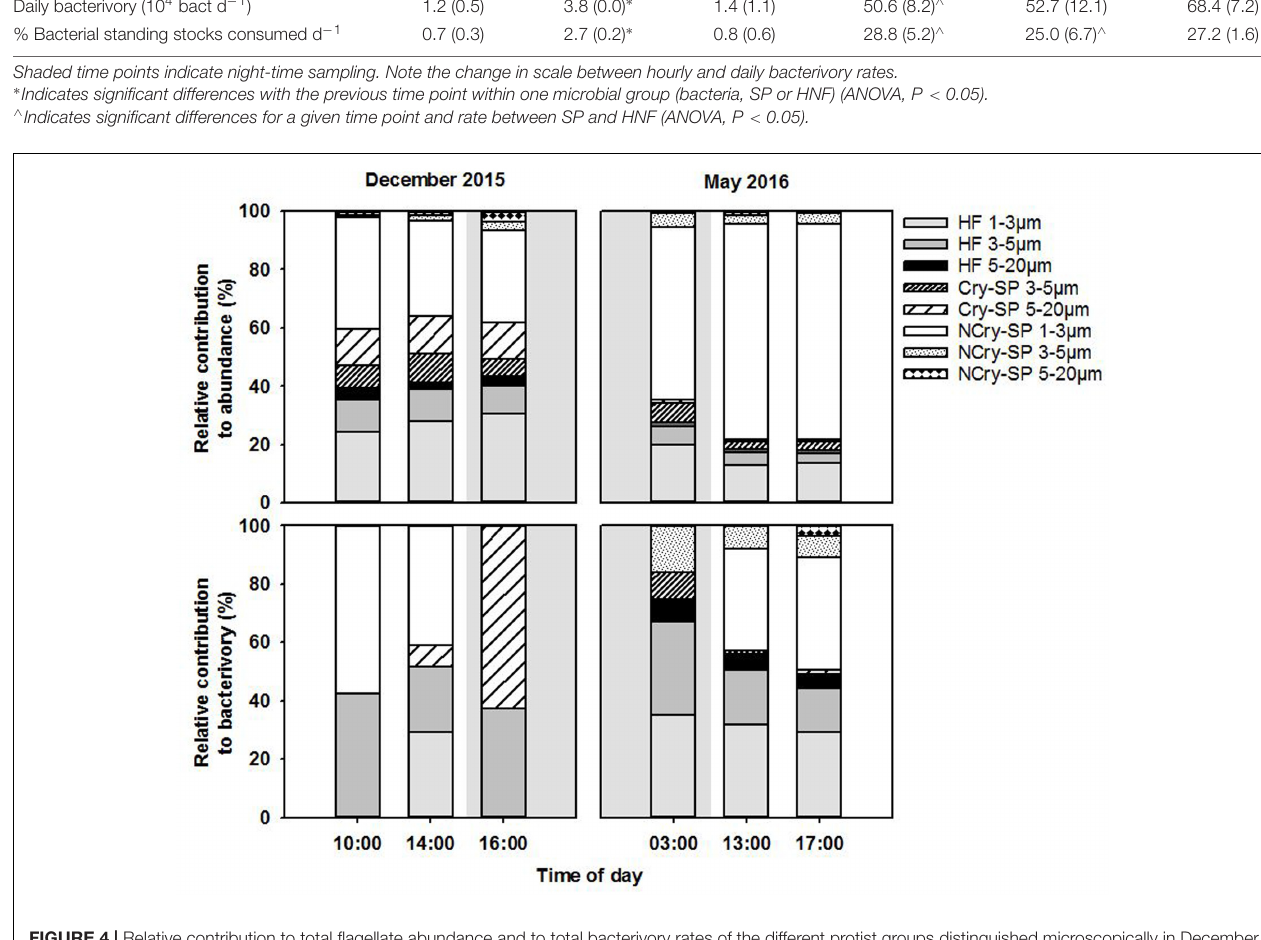
FIGURE 4 | Relative contribution to total flagellate abundance and to total bacterivory rates of the different protist groups distinguished microscopically in December 2015 and May 2016. Shaded background areas indicate night-time